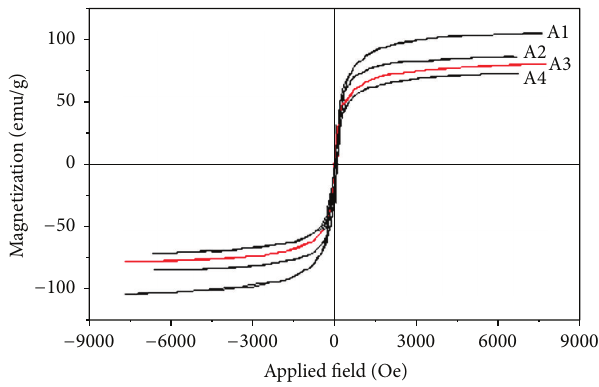
Figure4:Magnetizationversusappliedfieldformagnetitenanopar- ticles prepared at different temperatures: (A1) 273 K; (A2) 283 K; A3) 293 K; and (A4) 303